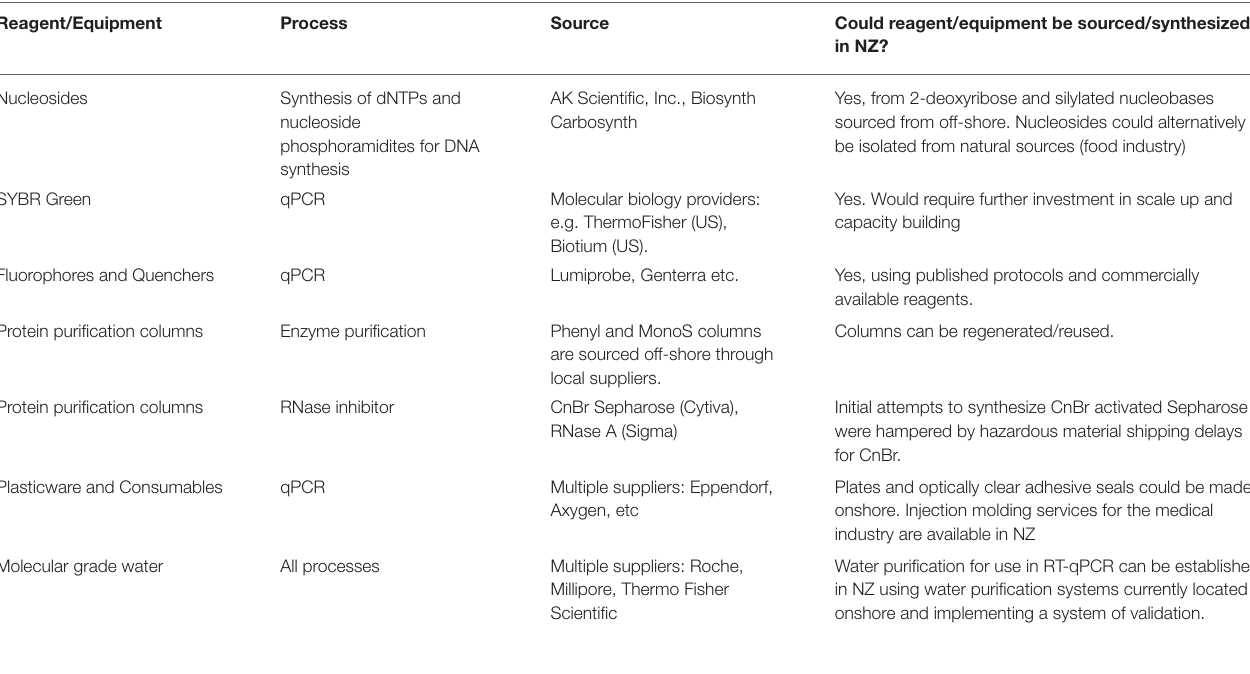
TABLE 2 | Examples of components used the are not sourced